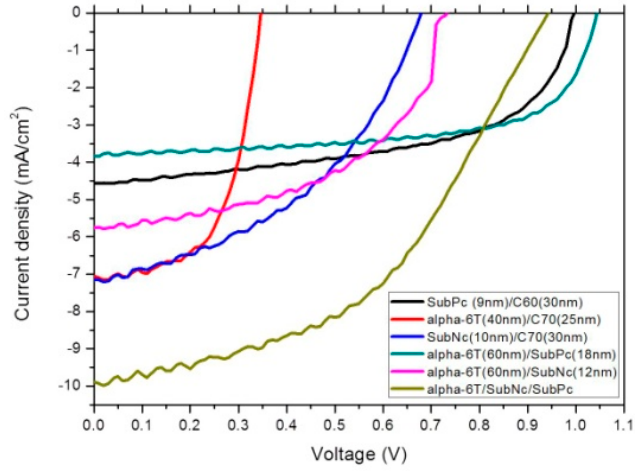
Figure 2. The current density-voltage (J-V) characteristic of these devices with various donor and acceptor materials.